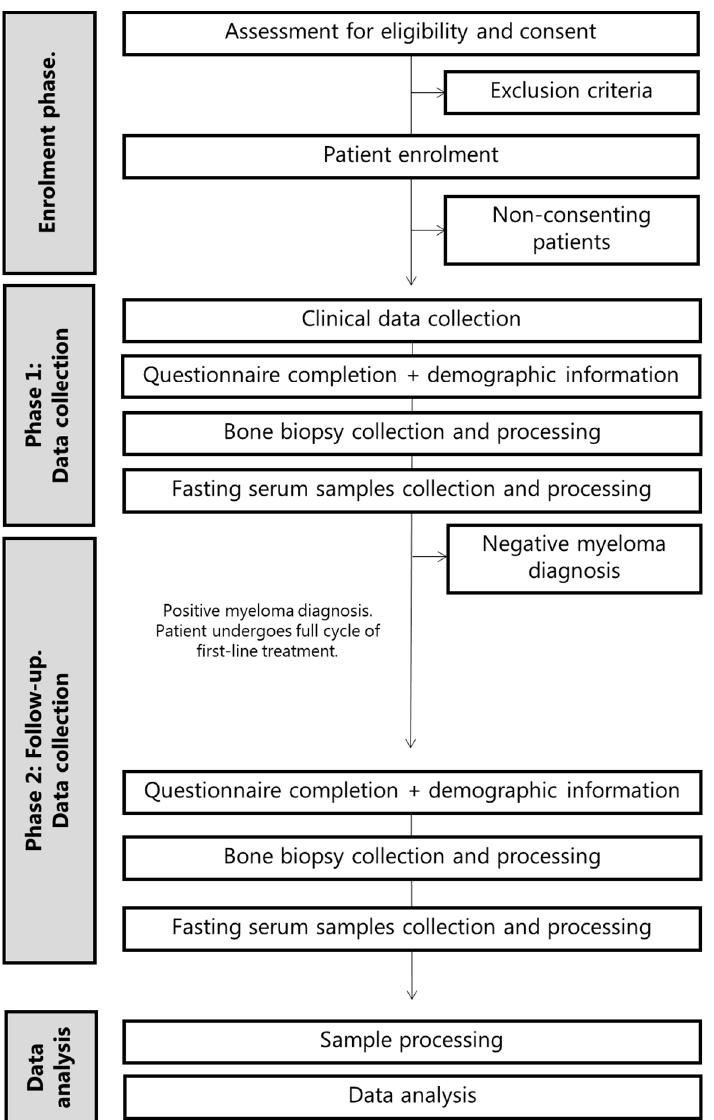
Figure 1. Flow diagram indicating the study design.